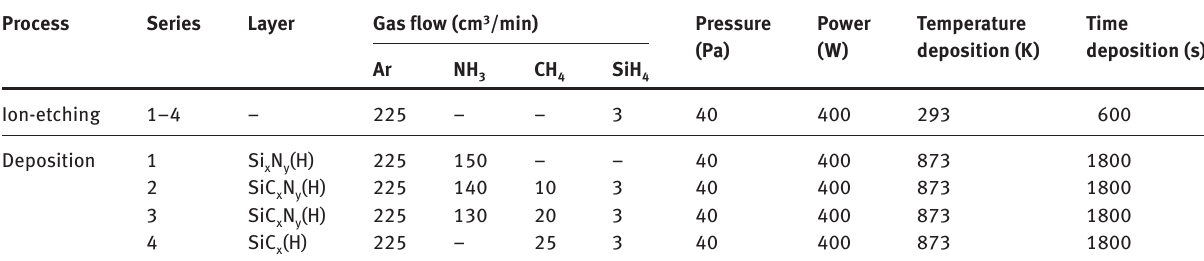
Table 1: The parameters of the deposition process applied in MWCVD system during deposition of layers.